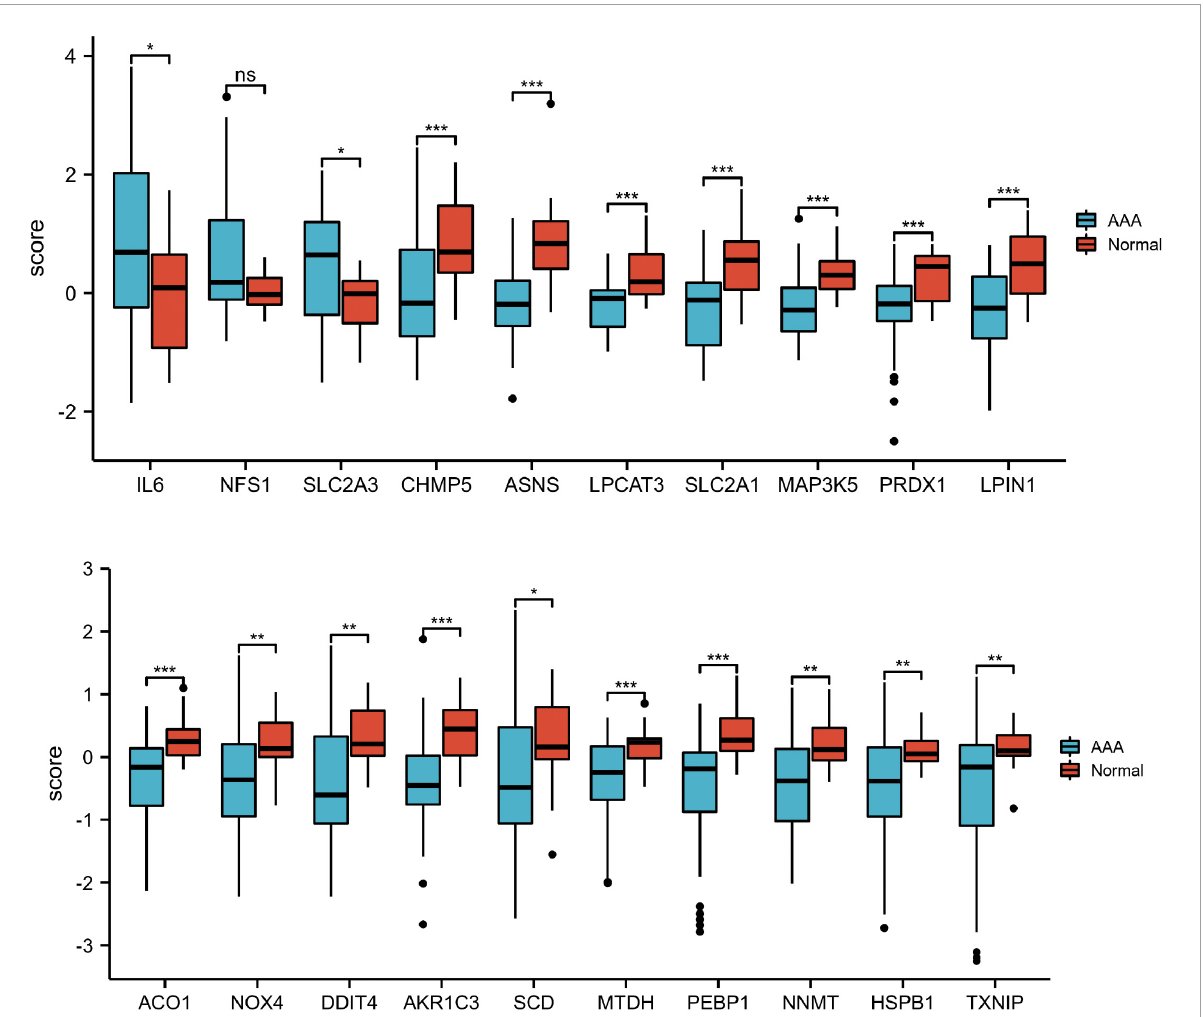
FIGURE3 Boxplot of 20 differentially expressed ferroptosis-related genes in AAA and healthy samples. The “score” on the Y -axis represents relative gene expression. The blue and red boxes represent AAA and healthy samples, respectively. * P < 0.05; ** P < 0.01; *** P < 0.001. AAA, abdominal aortic aneurysm; FC, fold change; ns, non-significant; PCA, principal component